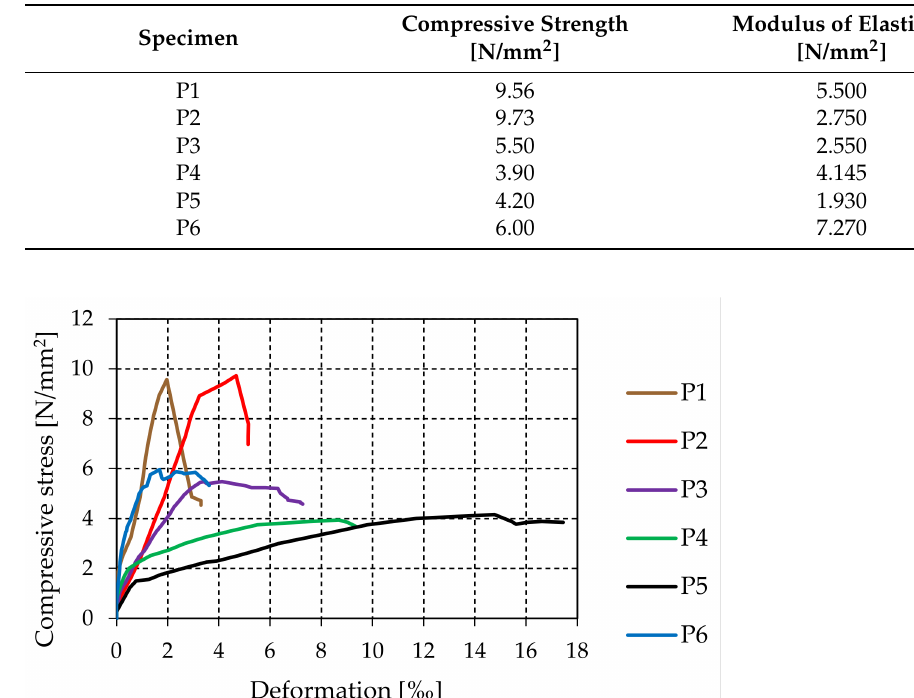
Table 1. Results of compressive strength and elastic modulus tests on masonry prisms.